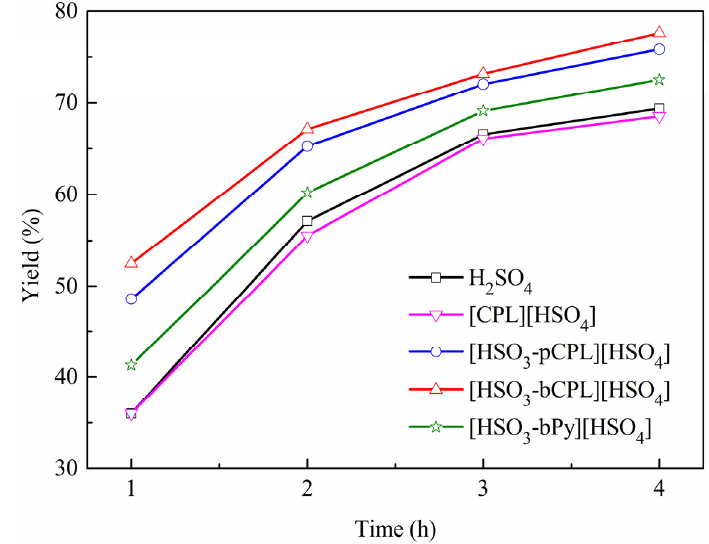
Figure 3. Effect of the ILs on the transesterification of Jatropha oil with methanol. Reaction conditions: temperature = 100 °C, methanol/oil/IL (molar ratio) = 6/1/0.2.